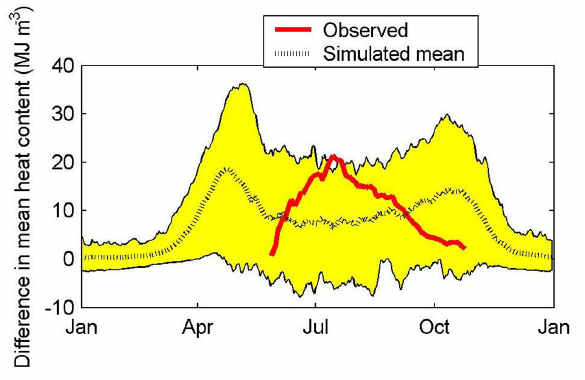
Fig. 6. Difference in the simulated yearly seasonal heat content in lake Halsj¨arvi (0–5m) between randomly selected years of con- trol (1961–1990) and future climate (2071–2100) simulation peri- ods. The yellow area denotes the 95% credible interval and the black dashed line the mean of simulations in uncertainty analysis, taking into account MyLake model parameter uncertainty and two different general circulation model boundary forcings (ECHAM4 and HadAM3) for the regional climate model. The red line denotes similar mean heat content difference observed in the large-scale lake manipulation experiment between the lake Valkea-Kotinen (non-manipulated control lake) and the manipulated (artificially in- creased mixing) Halsj¨arvi in 2005–2006 (see Fig. 5). Average heat content (in MJ) per m 3 water is used as the unit and this is propor- tional to the mean temperature of lake water mass (conversion from units of MJm − 3 to ◦ C by dividing values on y-axis by